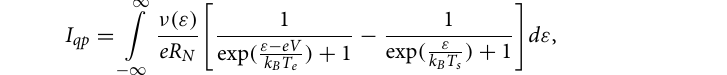
Figure 3. ( a ) Electron temperature obtained from HBE (2) versus voltage for three samples at T ph triangles for the sample A, circles for the sample B, rectangles for the sample C. Diamonds are for the sample C at 256 mK. ( b ) Minimal electron temperature versus phonon temperature. Blue curves are calculated for various fixed β (0.0,0.2,0.4 and 0.6) and zero I A . ( c ) Minimal electron temperature versus phonon temperature. Red curves are calculated for various I A and zero β . I A changes from 30 pA to 4 nA. Thick black solid curve